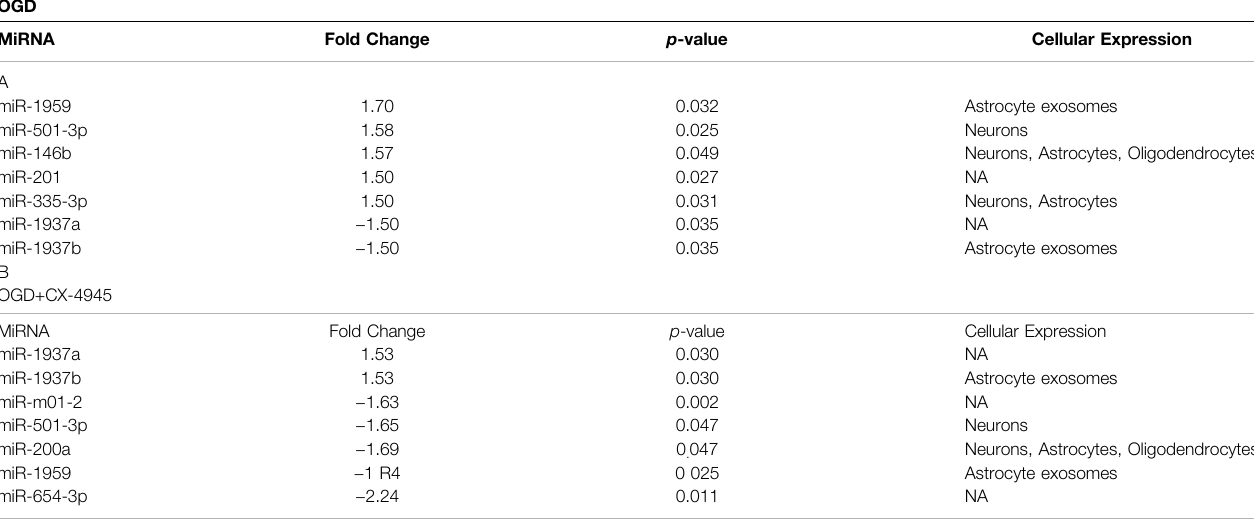
TABLE 1 | List of miRNAs with fold changes after OGD and OGD with CK2 inhibition and their cellular expression. OGD MiRNA Fold Change p -value Cellular